Question: Write a single sentence explaining what this figure depicts.
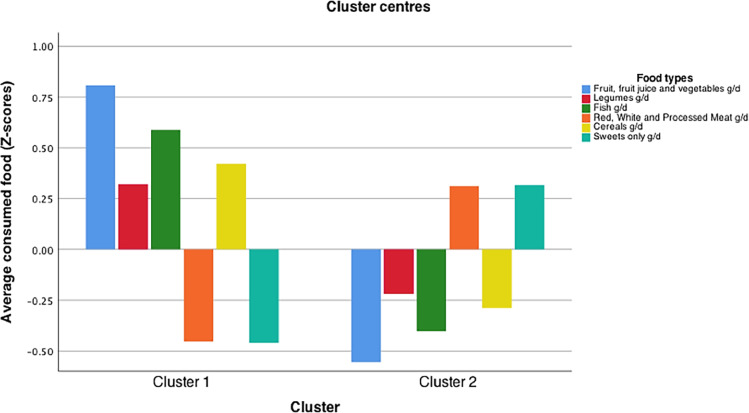
Answer: long description. The optimised and cross-validated K-means cluster model of dietary intake data from the MEDDINI study. Model developed using the K-means cluster algorithm in SPSS (version 26). Y-axis shows food intake data represented as standardised z -scores. X axis the resultant clusters after optimisation and cross validation. Food groups included into the cluster model were: ‘fruit, fruit juice and vegetables’, ‘legumes’, ‘fish’, ‘red, white and processed meat’, ‘whole grain cereals’, ‘sweet foods’.